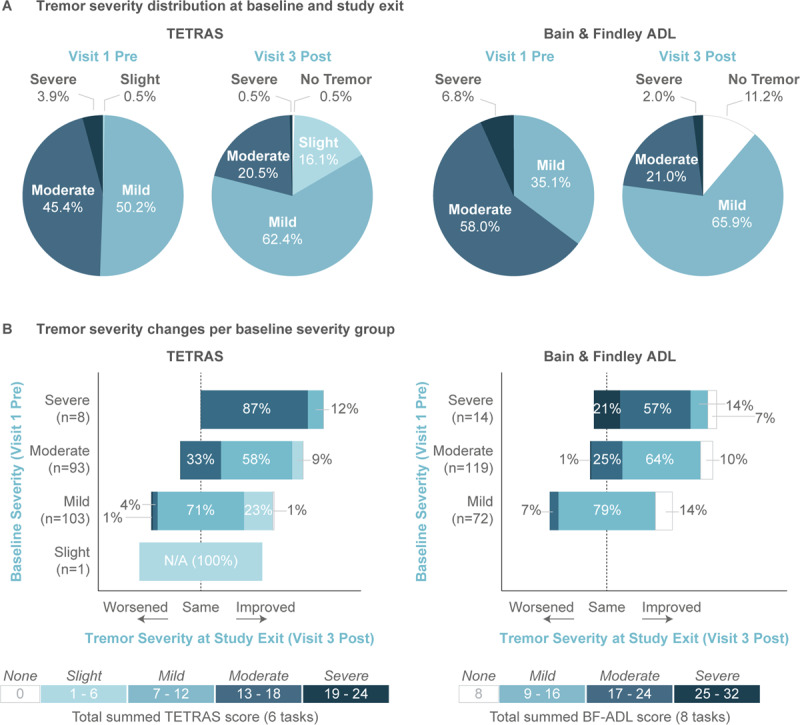
Tremor severity distributions shifted towards milder tremor at study exit. (A) The distribution of tremor severity at the time of co-primary endpoints (i.e., Visit 1 pre-stimulation to Visit 3 post-stimulation) were assessed for TETRAS (left) and BF-ADL (right). On both scales, the distribution of tremor severity shifted towards milder tremor. (B) Study exit (Visit 3 post-stimulation) tremor severity distributions were broken down for each baseline severity group for TETRAS (left) and BF-ADL (right). Most patients improved in tremor severity relative to their baseline or stayed in the same severity classification, with more severe patients showing greater improvement. Severity categories were defined consistent with TETRAS guidelines.